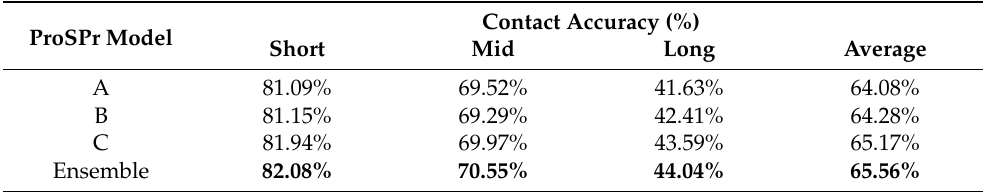
Table 1. CASP14 contact accuracies (see text for definition).